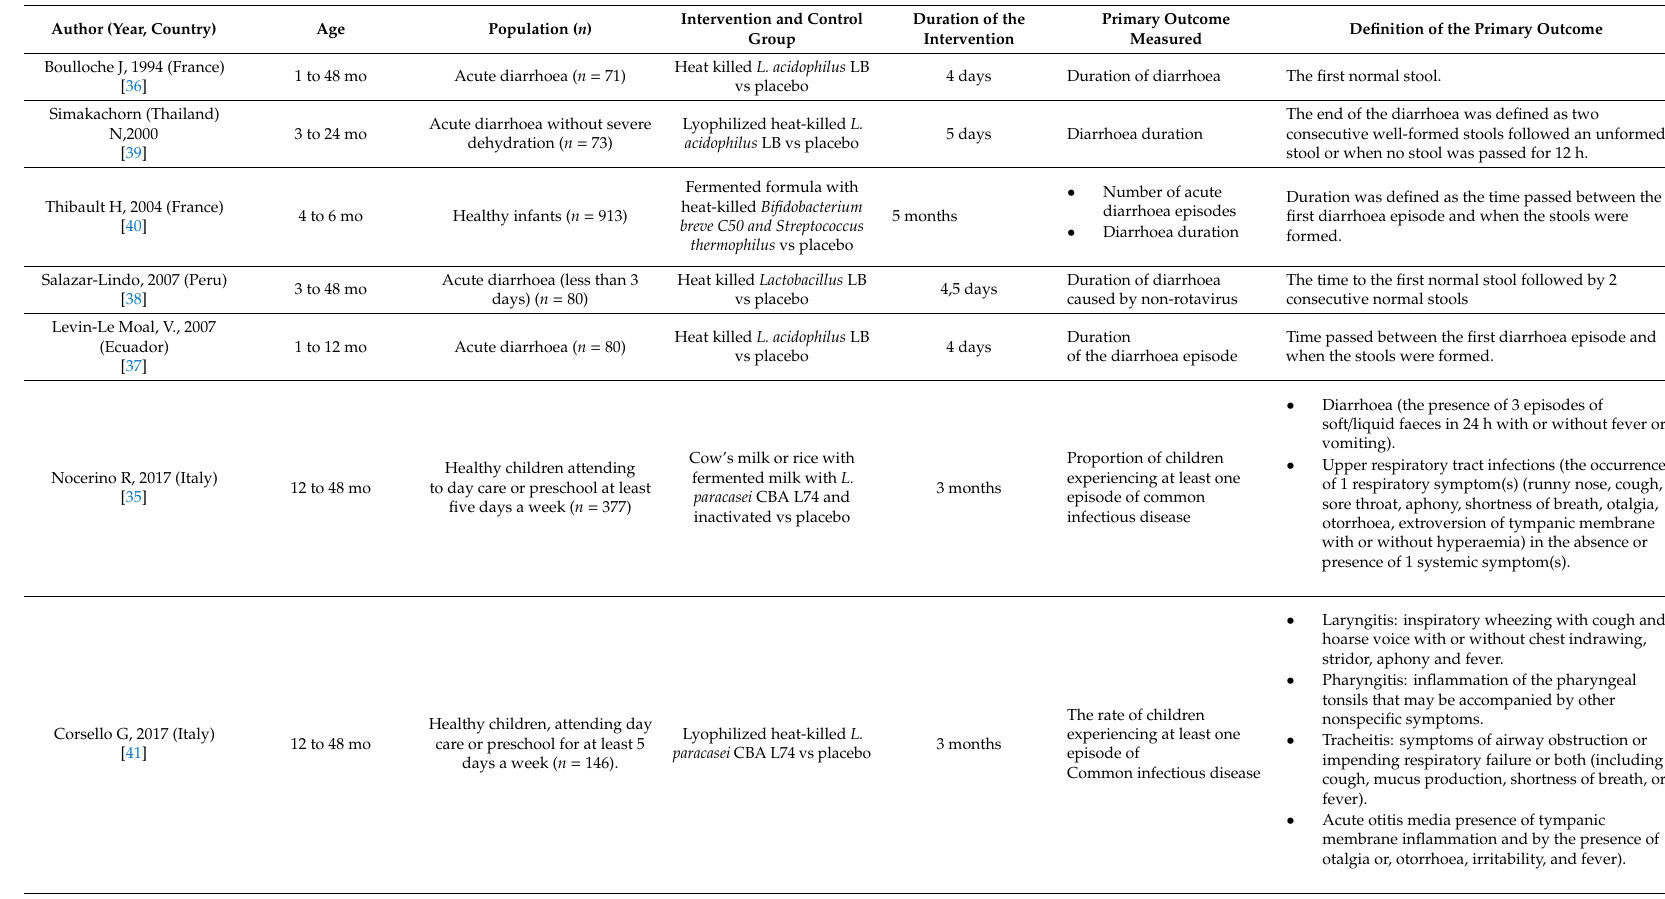
Table 1. Principal characteristics of the analysed